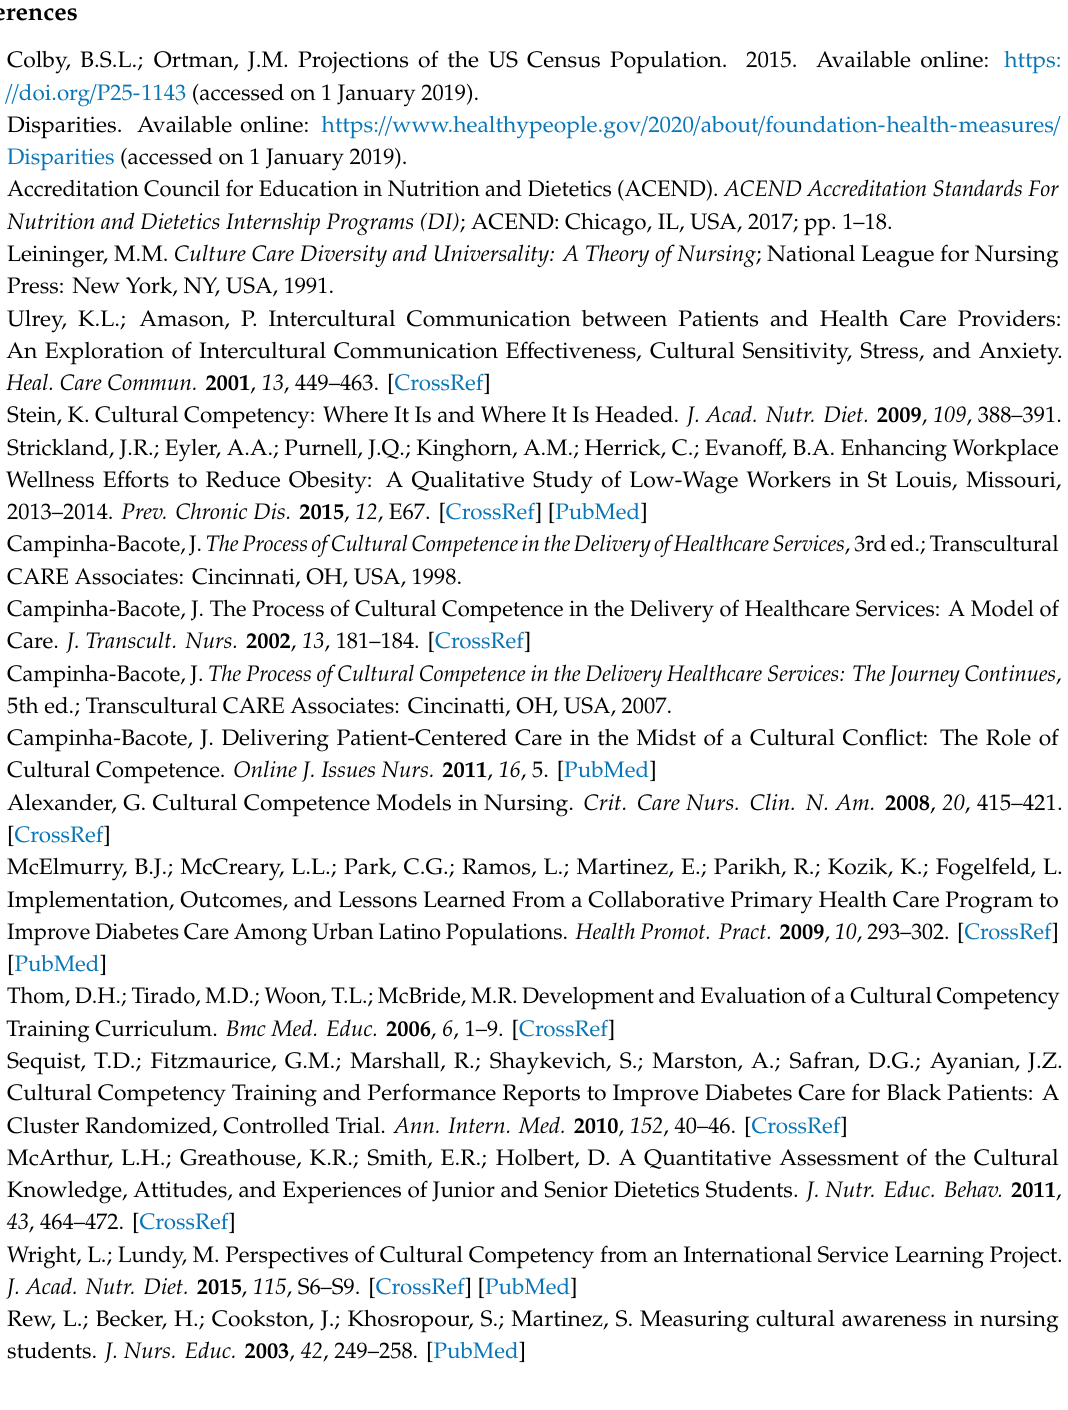
Table S1: Culture